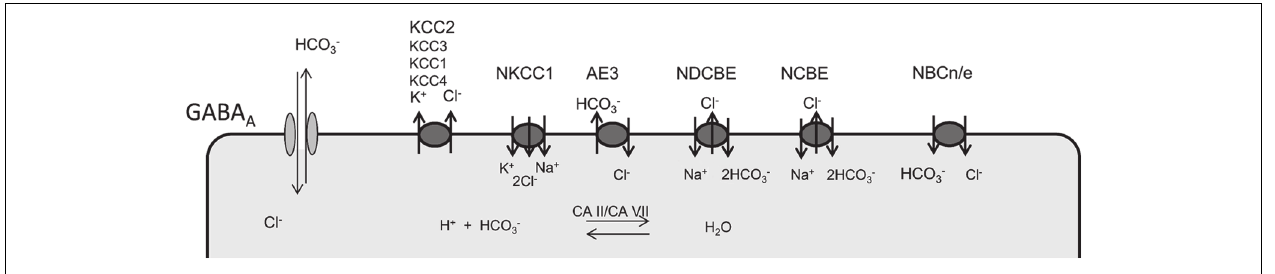
bicarbonate transporters can be sub-classified in Na + dependent (NDCBE, NCBE) and Na + independent anion exchangers (AE1,2,3). According to the stoichiometry Na + -coupled bicarbonate co-transports can be either electroneutral (NBCn) or electrogenic (NBCe). Although carbonic anhydrases cannot change the existing bicarbonate gradients, they promote anion- transport by members of the SlC4A family and replenish bicarbonate levels.